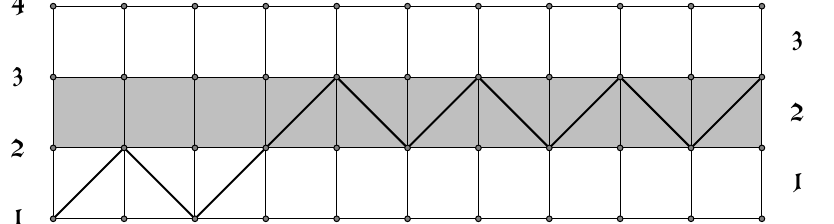
Figure 5 . A non-minimal path in the restricted solid-on-solid model L 2 ; 5 , labeled by a = 1, b = 2, and c = 3, that contains a valley at ( x; y ) = (1 ; 1) of weight wt = 1 + 1 =